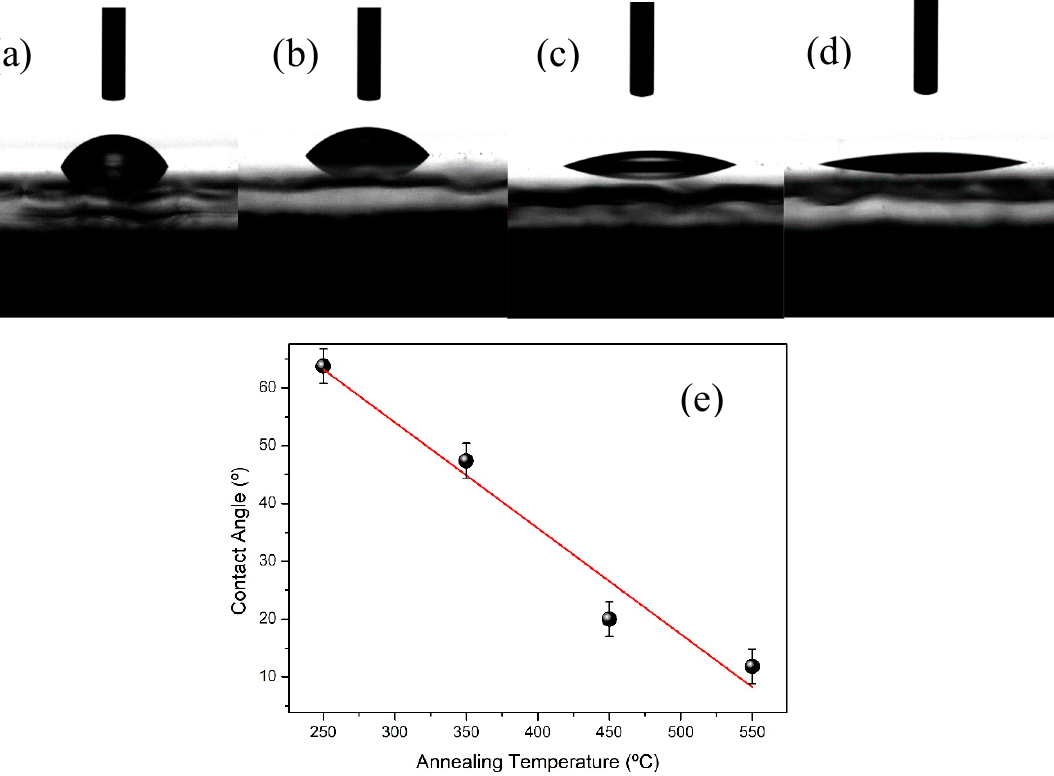
ff erent annealing temperatures 2 thin films at di